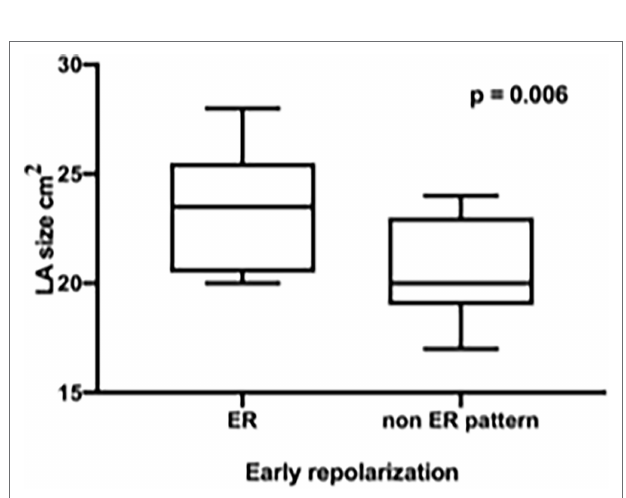
FIGURE 3 | Significantly enlarged LA endsystolic diameter in professional basketball players with early repolarization (ER) compared to non-ER pattern.